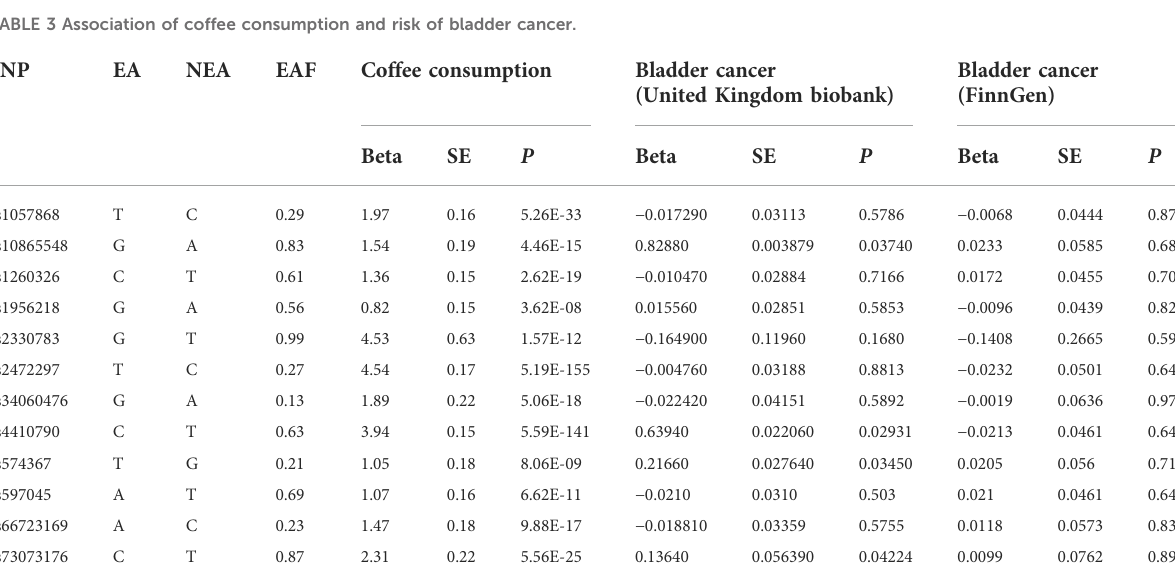
TABLE 3 Association of coffee consumption and risk of bladder cancer.